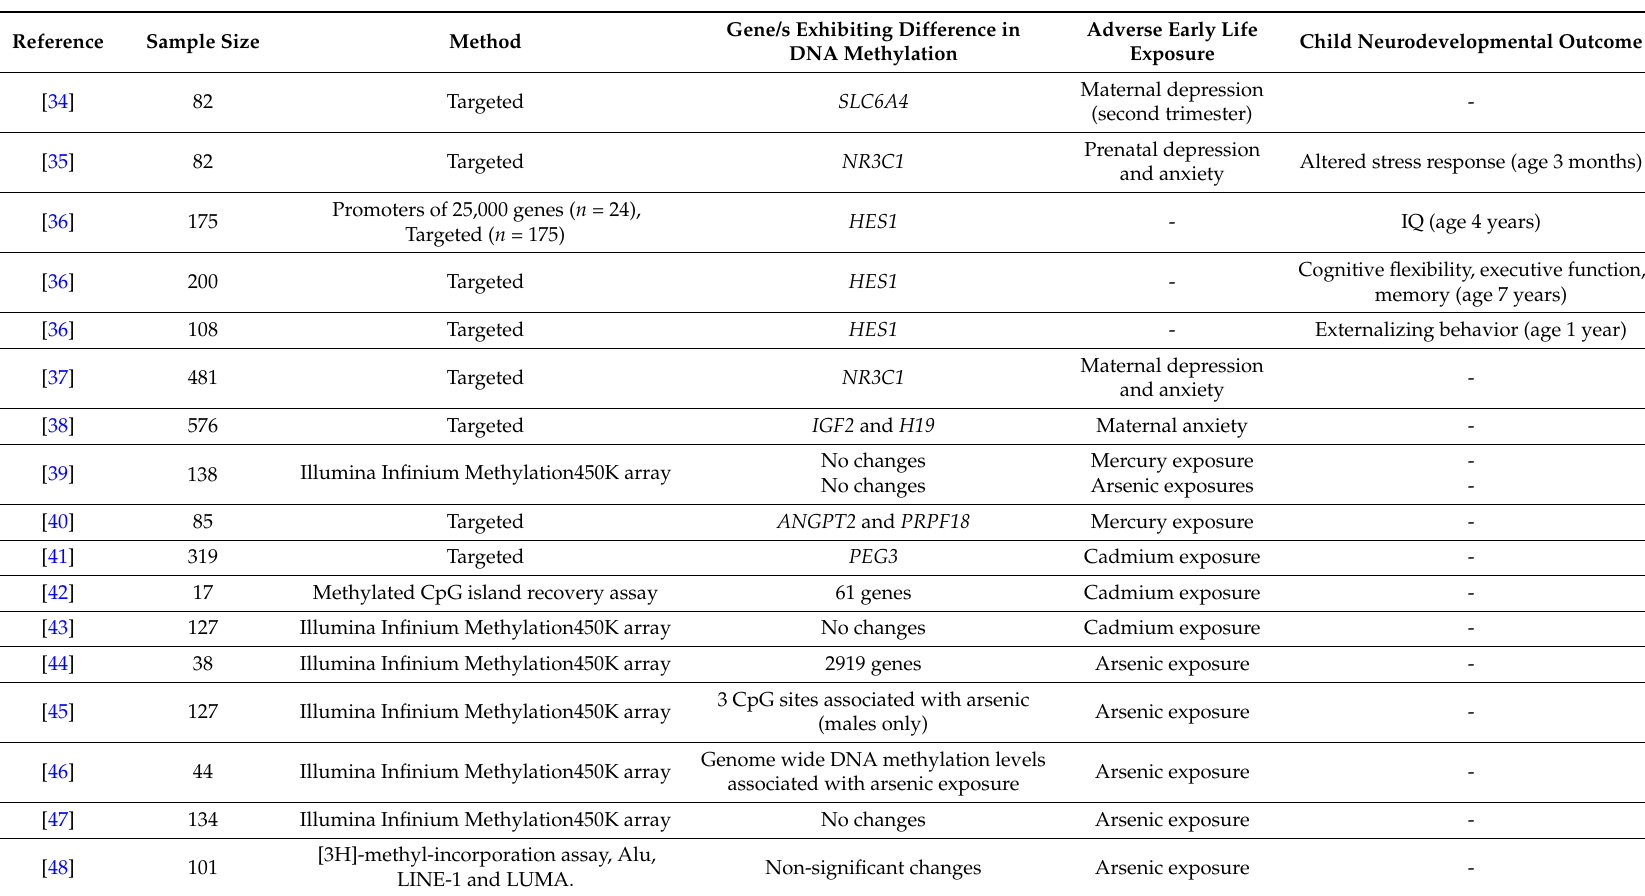
Table 1. Summary of studies assessing changes in cord blood DNA methylation and their association with an adverse prenatal exposure and/or child neurodevelopmental